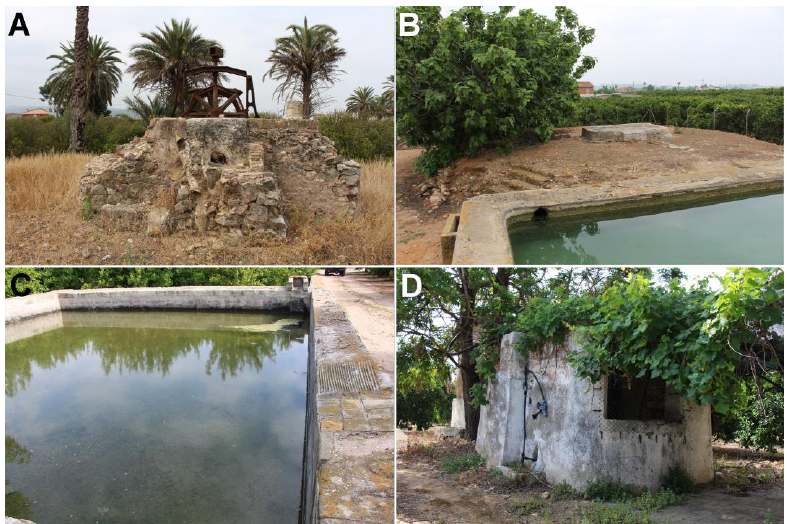
Figure 12. ( A ) Cast-iron waterwheel located in the vegetable garden of Casa de la Boquera. ( B ) Well and threshing floor with the stairs of the waterwheel at Casa de Agustín, in the Camí de Bernabé in Alzira. ( C ) Well of the waterwheel at Casa de Blanc, in Carcaixent. Note the washing slab fixed on the side facing the house. ( D ) The well and the rest of the structure of the ‘raised shaft’ waterwheel at the Casa de Noguera. Source: Authors.